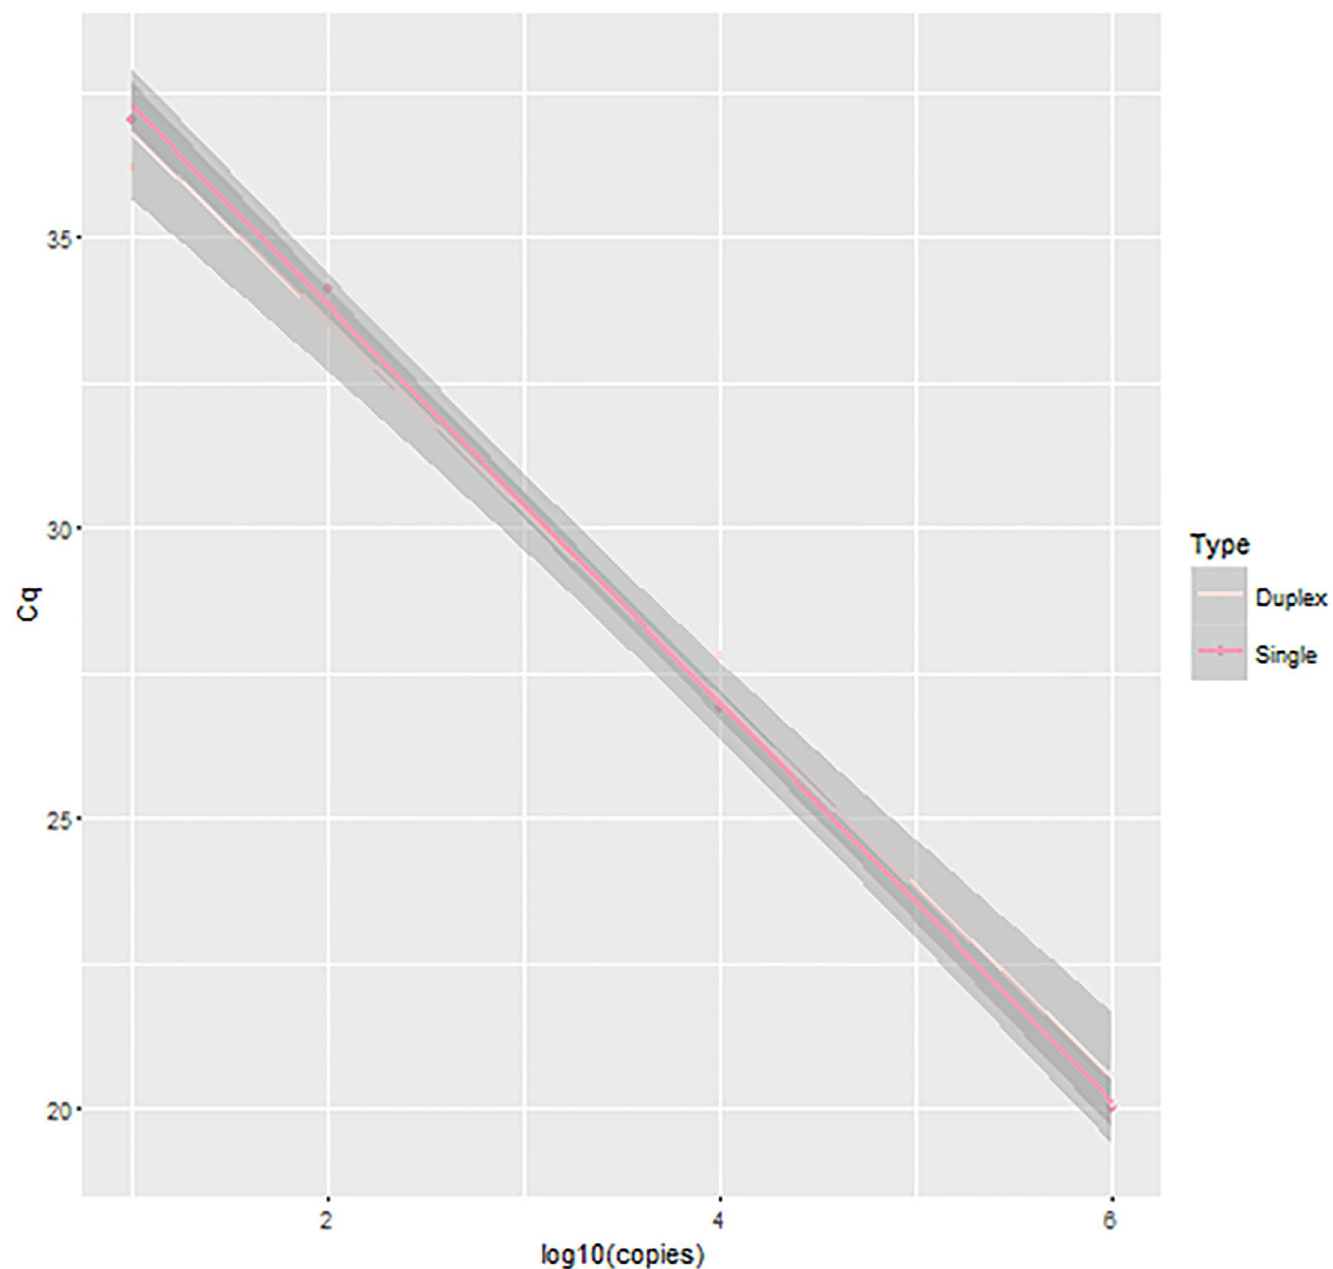
Fig 1. Standard curves from the duplex and single quantitative PCR reactions. Both curves were generatedfrom standards (10 6 − 10 1 ) run in triplicate. For the duplexreaction r 2 = 0.994 and the slope = -3.3 and for the single reaction the r 2 = 0.998 and the slope = -3.4.